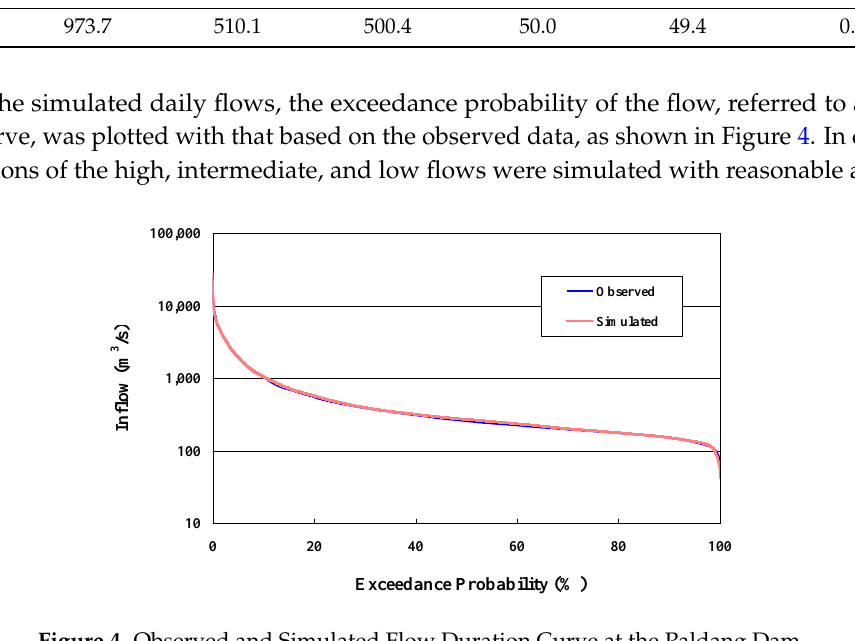
Figure 4. Observed and Simulated Flow Duration Curve at the Paldang Dam.